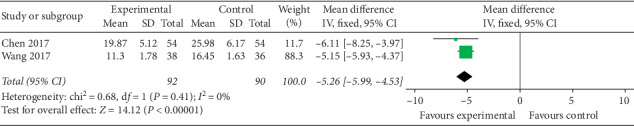
Forest plot of experimental groups versus control groups: TCM syndrome score.